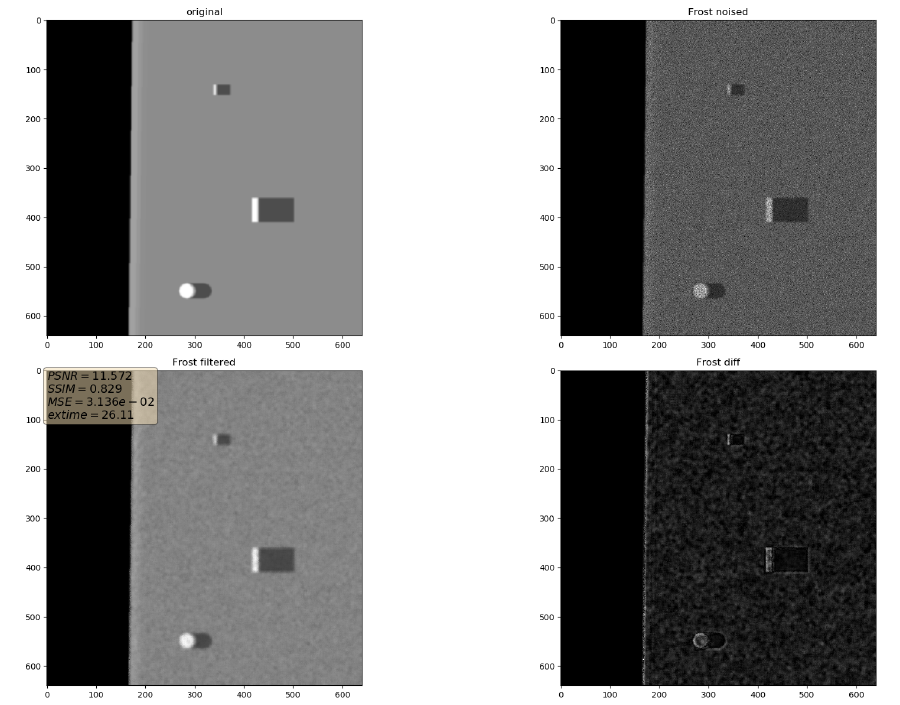
Figure 10. Filtering results for Frost filter. Speckle noise σ 2 = 0.05.